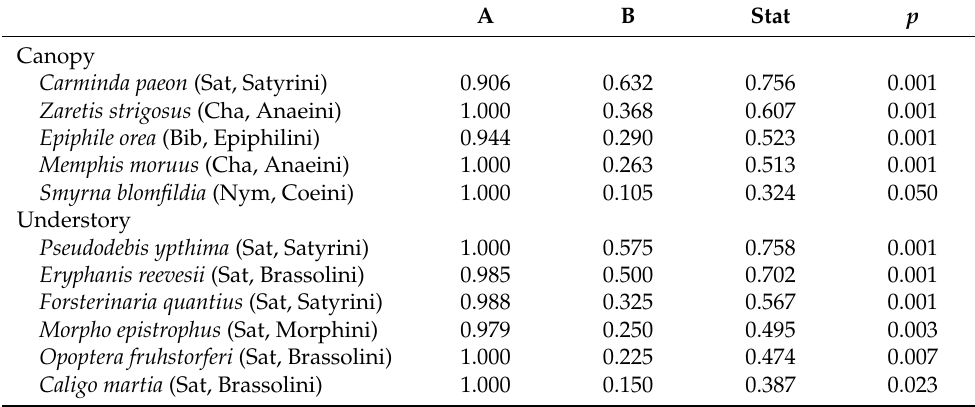
Table 4. Indicator species analysis (IndVal), showing the values of fidelity (A) and specificity (B) for fruit-feeding butterflies between the canopy and understory sampled in a mixed ombrophilous forest in southern Brazil, during November 2016–March 2017 and October 2017–March 2018. Names in the parentheses indicate the subfamily and tribe, respectively. Sat—Satyrinae, Cha—Charaxinae, Bib—Biblidinae, Nym—Nymphalinae. Only species with p values < 0.05 are shown. A